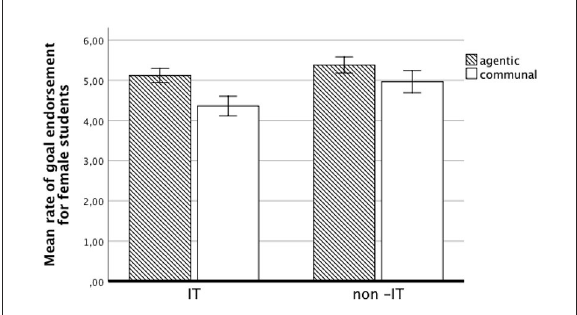
FIGURE1 Mean rate of goal endorsement for female students.